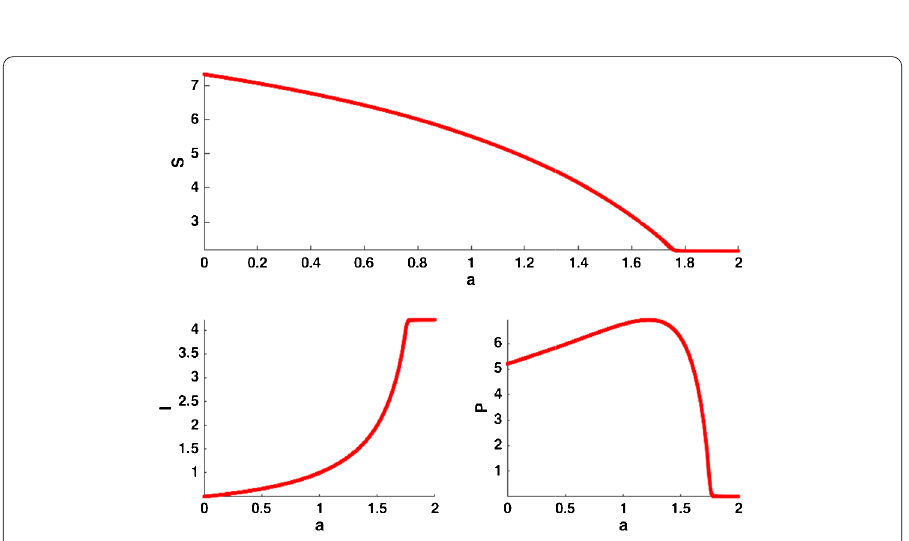
Figure 12 Bifurcation diagram of the fractional-order model (3) with respect to half saturation constant ( a ) when q =